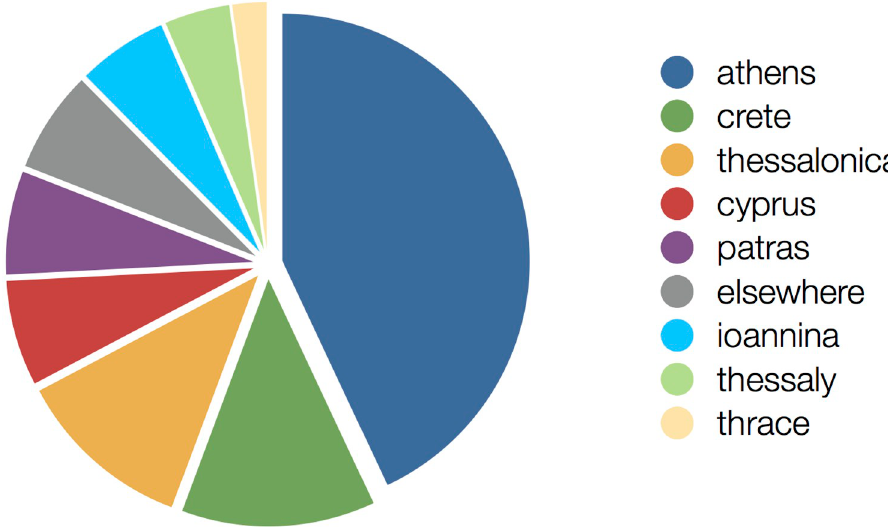
Fig 1. Bioinformatics activity in Greece and Cyprus. Relative distribution per region in Greece and Cyprus (entire country) in terms of volume of bioinformatics-related publications, as an indicator of research activity (measured until October